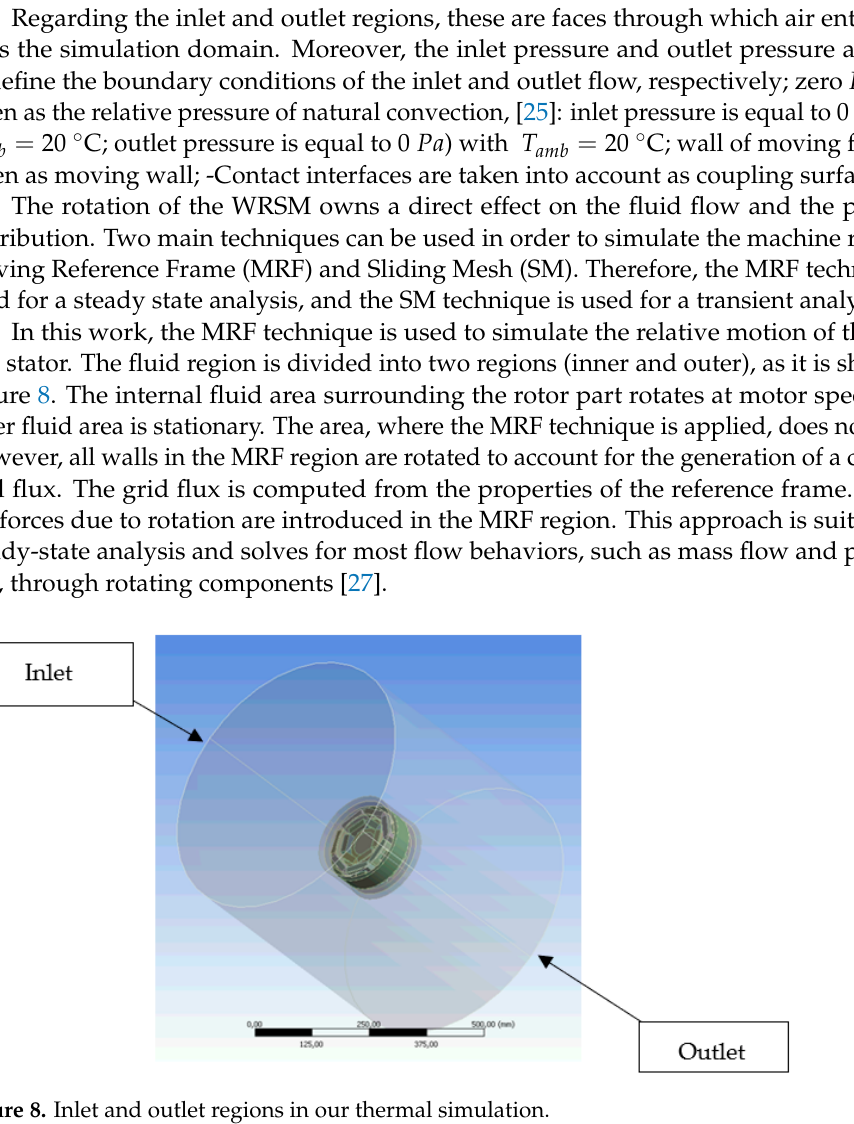
Figure 8. Inlet and outlet regions in our thermal